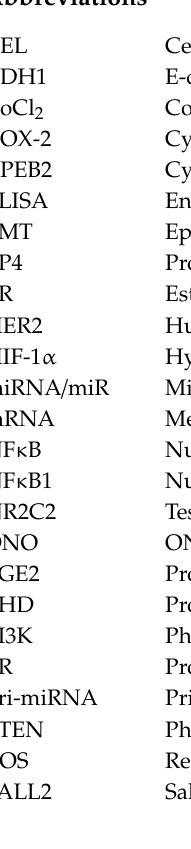
Figure S1: CoCl 2 dose-response assay; Figure S2: miRNA, pri-miRNA and COX-2 expression in various cell lines; Figure S3: Western blot analysis to measure endogenous HIF-1 α expression in various breast cancer cell lines; Figure S4: MCF7-miR526b and MCF7-miR655 cell densities increase due to hypoxia; Figure S5: MCF7-miR655 cell migration in normoxia and hypoxia; Figure S6: Hypoxia-enhanced vascular mimicry and inhibition of tube formation with COX-2-I, EP4A and PI3K / Akt-I; Figure S7: Inhibition of hypoxia-enhanced migration for MCF7-miR655